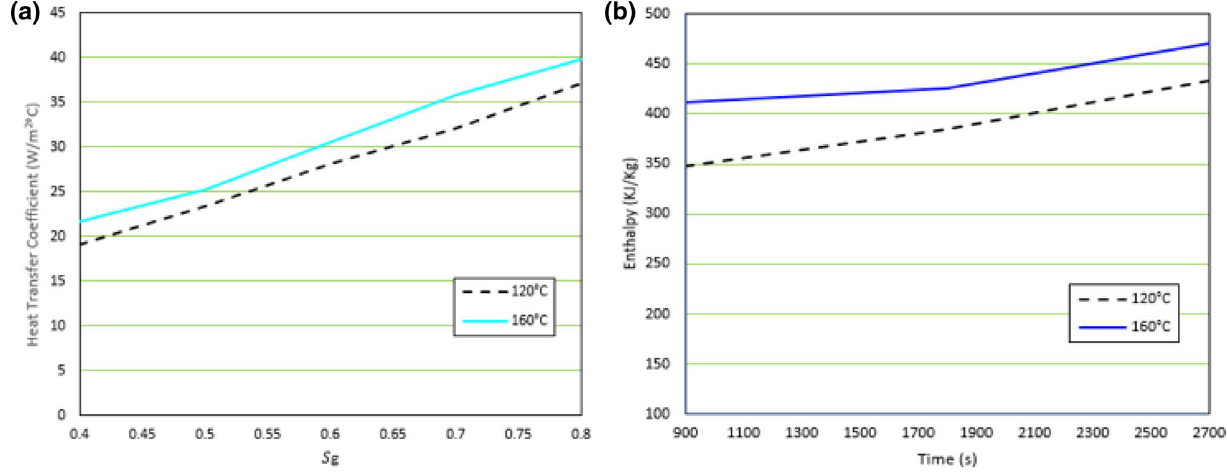
Fig. 5 a Heat transfer coefficient variation for increasing water saturation, b enthalpy variation for increasing